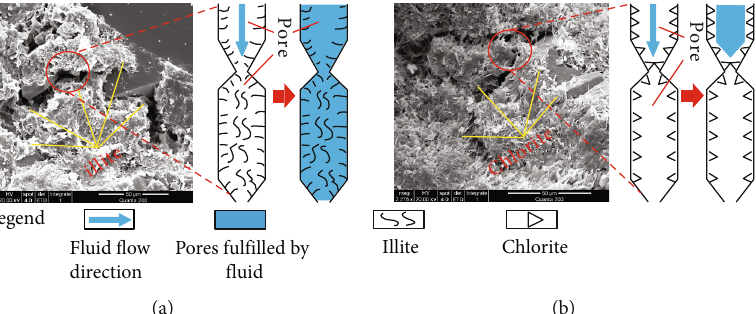
Figure 13: SEM imaging and schematic diagrams of the brine charging process. (a) Type N1 sandstone from S65; (b) type N2 sandstone from